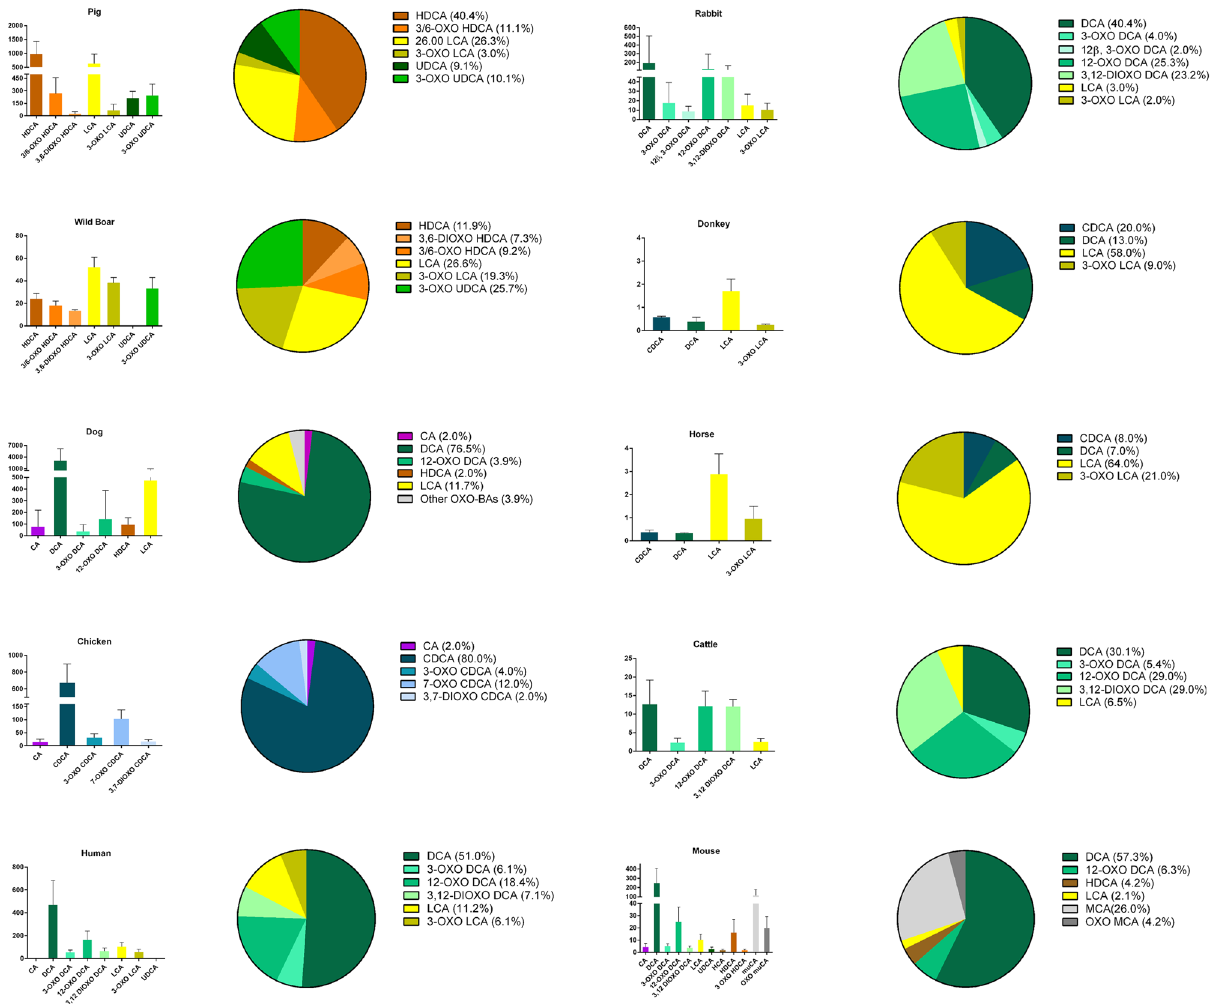
Figure 4. Column charts (absolute content in µg g −1 ) and pie charts (%) of the fecal bile acid and oxo bile acid compositions in the investigated